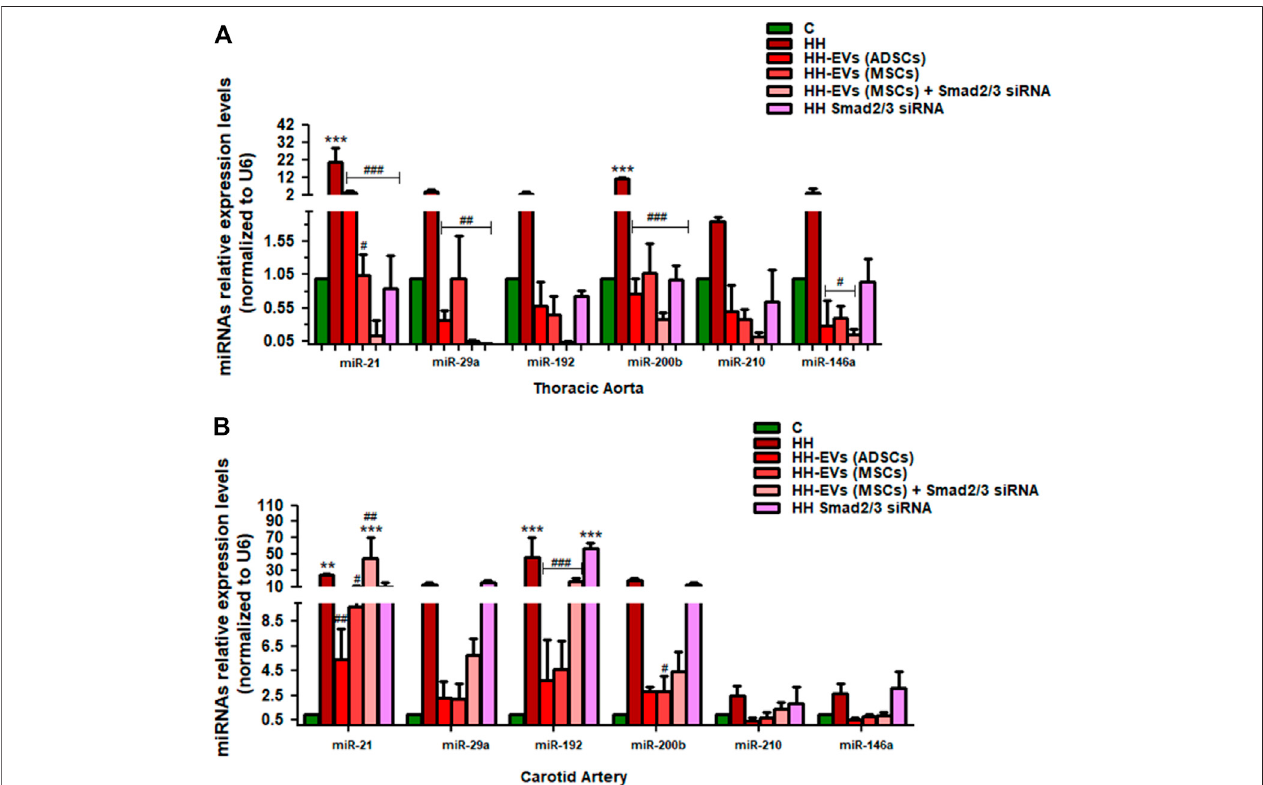
FIGURE 12 | Relative expression levels of six miRNAs (miRNA-21, miRNA-192, miRNA-200b, miRNA-29a, miRNA-210, and miRNA-146a) extracted from two types of tissue (A) thoracic aorta (B) and carotid artery, explanted from all groups of investigated animals. Total RNA was extracted and used for RT-qPCR. The expression of the miRNA panel was validated using three tissue samples from each artery and matched normal tissue samples. The miRNA expression was normalized using snRU6asareferencegene. p -valuesofsigni fi cantdifferencesbetweenthegroupswerecalculatedandrepresented as*** p < 0.005,** p < 0.01, * p < 0.05for values vs. control group and ### p < 0.005, ## p < 0.01, # p < 0.05 for values vs. HH group (two-way ANOVA Bonferroni post-test analysis). The mean fold change in expression of the target miRNA was calculated using ΔΔ Ct = Δ Ct (a target sample) − Δ Ct (a reference sample). For the control sample, ΔΔ Ct equals 0 and 2 ° equals 1; therefore, fold change in gene expression relative to control equals